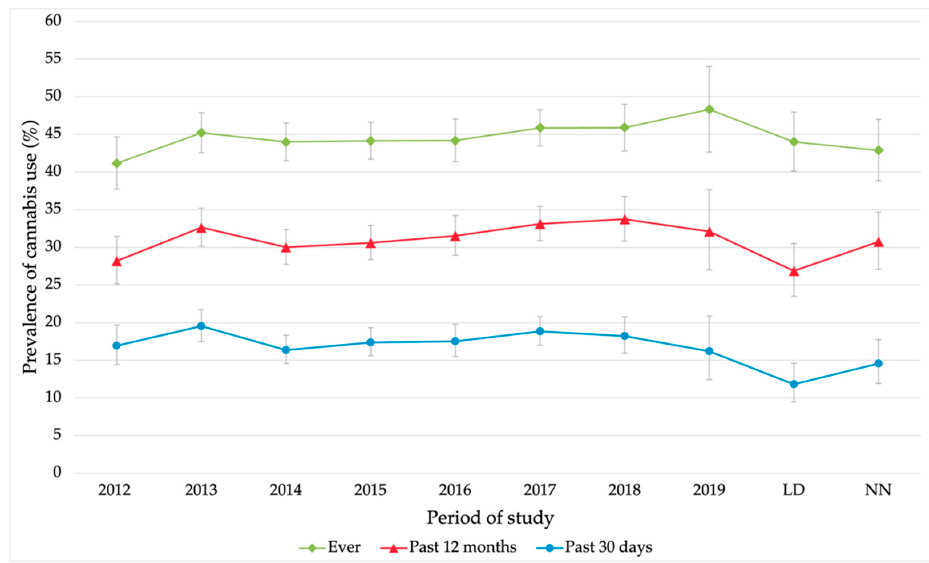
Figure 1. Evolution of the prevalence of cannabis use (%) in university students, ever, past 12 months and past 30 days. Error bars show the 95% confidence interval on the prevalence rates.